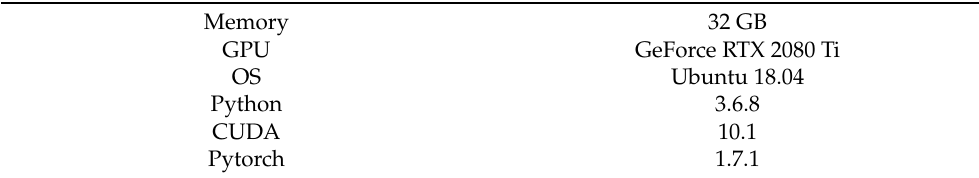
Table 2. Experimental conditions.